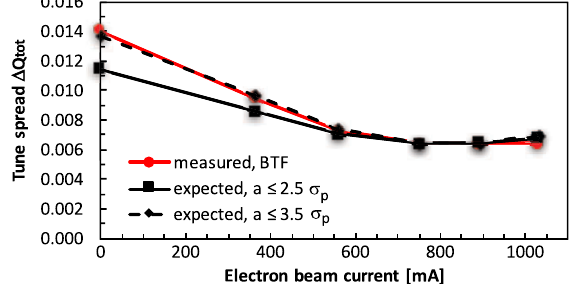
FIG. 18. Total tune spread Δ Q as a function of the electron tot beam current I . The measured total tune spread is based on BTF e measurements.The expected total tune spread is based on the measured tune spread Q 0 and the beam-beam parameters ξ and Al ξ using Eq. (13), and shown for a ≤ 2 . 5 σ and a ≤ 3 . 5 σ e p p